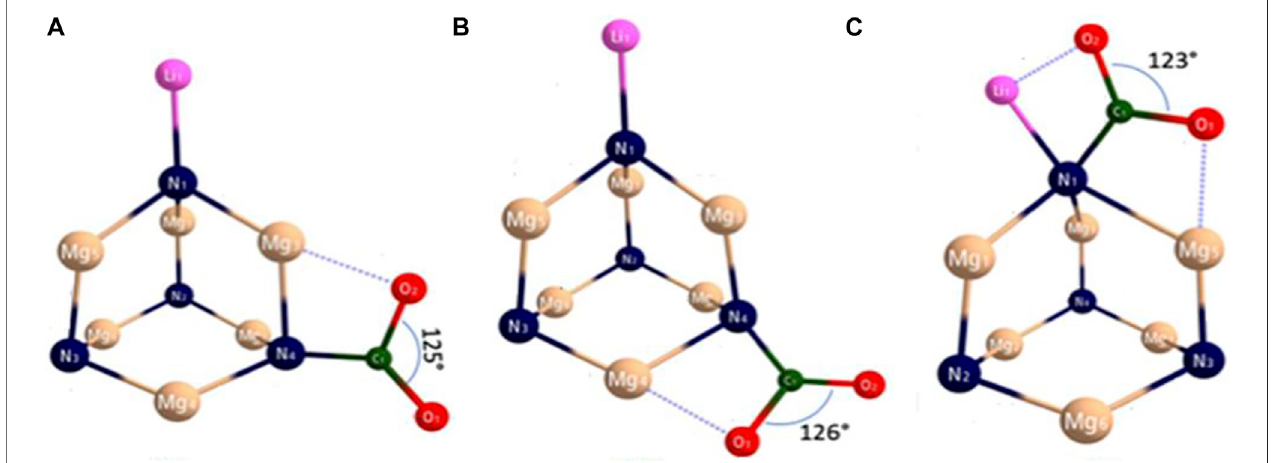
FIGURE 8 | Equilibrium structures of CO 2 complex with N 4 Mg 6 Li from Ref. 22 with the permission of the American Institute of Physics.